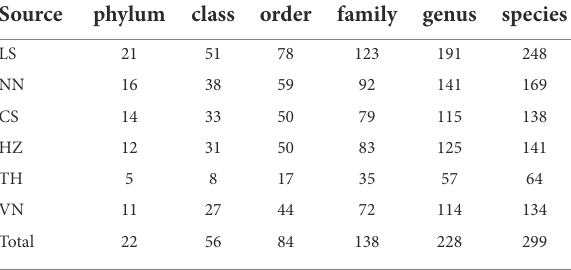
TABLE 2 Number of gut bacterial taxonomic categories in Cnaphalocrocis medinalis from different geographic